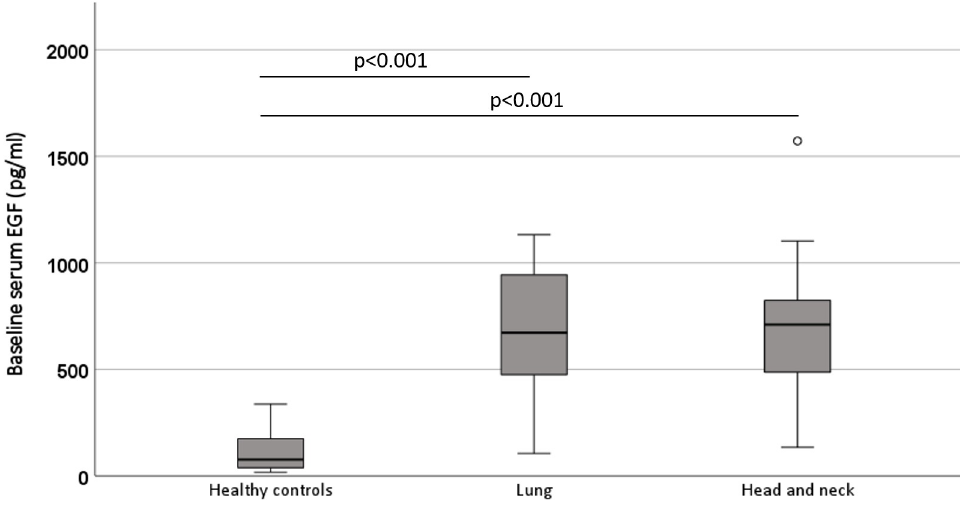
Fig 1. Simple boxplot of baseline serum EGF in healthy controls, patients with lung cancer and patients with head and neck cancer. The baseline serum EGF levels in both oncological populations were significantly higher compared to the healthy controls (p < 0.001). EGF: epidermal growth factor.